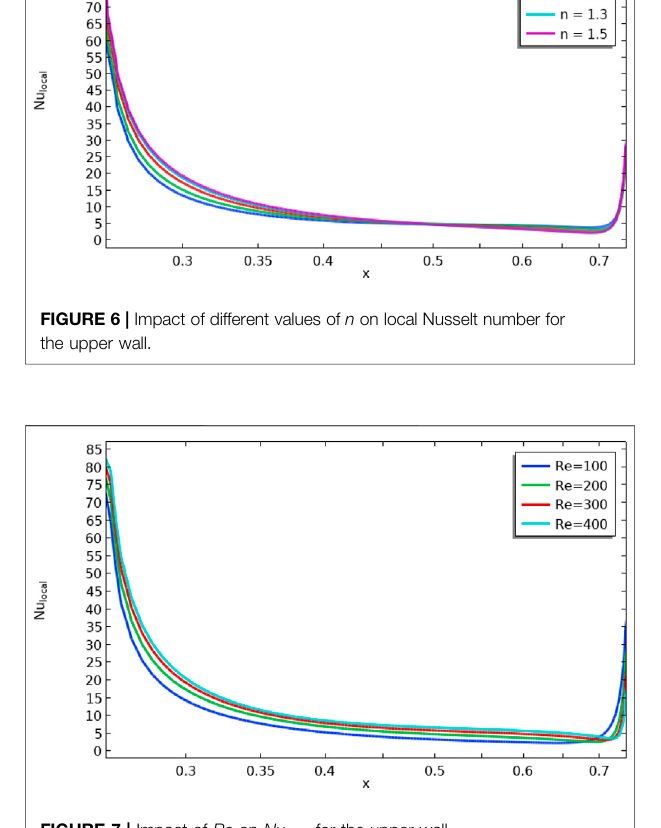
FIGURE 7 | Impact of Re on Nu local for the upper wall.